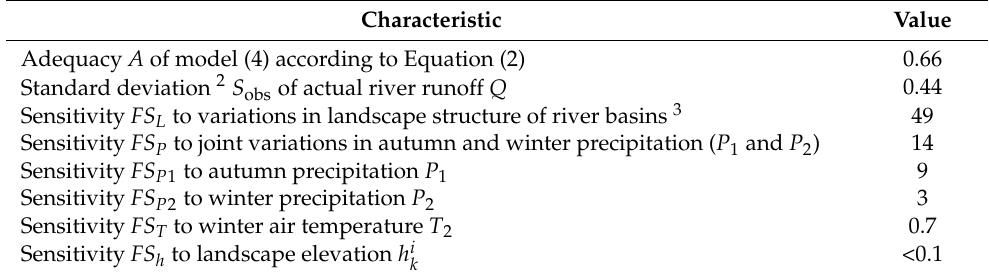
Table 3. Sensitivity FS 1 of model (4) to natural variations in environmental factors.